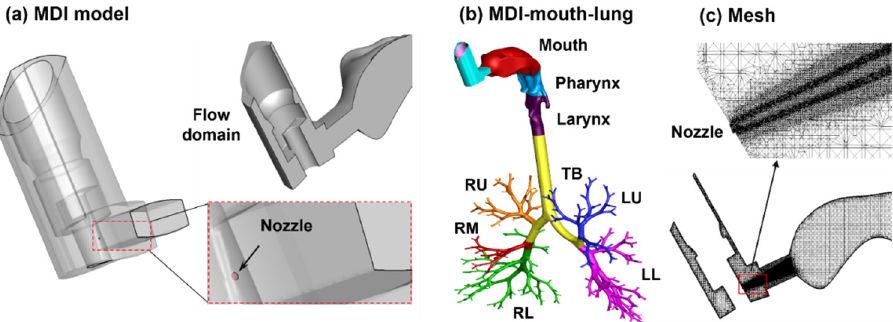
Figure 2. Computational model: ( a ) metered-dose inhaler (MDI) with an aerosol-exiting nozzle, ( b ) the integrated MDI–mouth–lung model, and ( c ) multi-block computational mesh with refined cells downstream of the nozzle. The airway model was divided into mouth, pharynx, larynx, tracheobronchial region (TB), and five lung lobes.